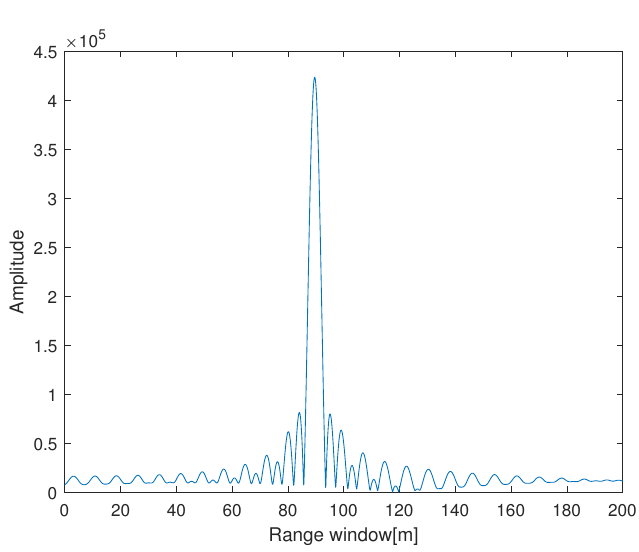
Figure 5. PCSNR at a nonideal VPA